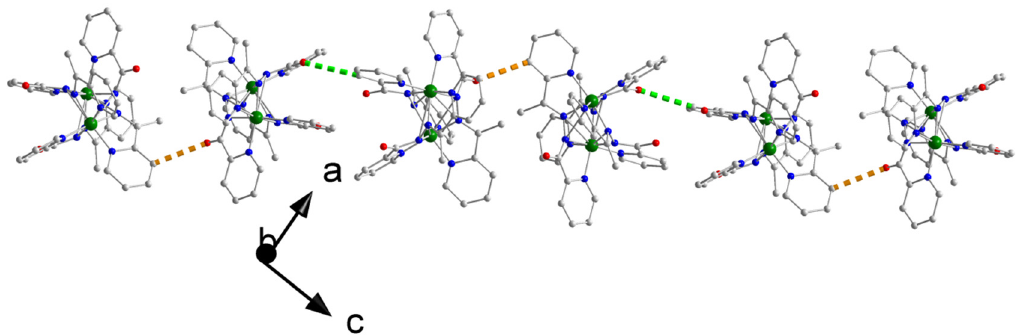
Figure 8. A chain of [Co 2 (L) 3 ] 3 + cations parallel to the [101] direction in the crystal structure of 3 · 0.8H 2 O · 1.3MeOH. The dashed orange and green lines indicate the H-bonding interactions C9-H(C9) ··· O1 and C17-H(C17) ··· O3, respectively. Atoms C9 and C17 are aromatic carbon atoms, not labelled in Figure 7 and Figure S21. Table 1. Selected interatomic distances (Å) and bond angles ( ◦ ) for complex 1 · 0.8H 2 O · MeOH a . Interatomic Distances (Å) Bond Angles ( ◦